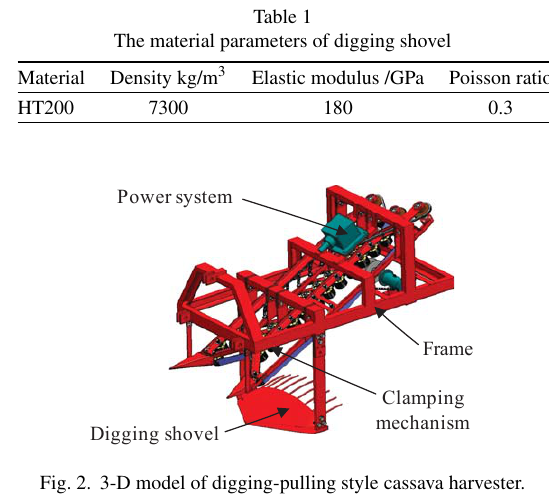
Fig. 2. 3-D model of digging-pulling style cassava